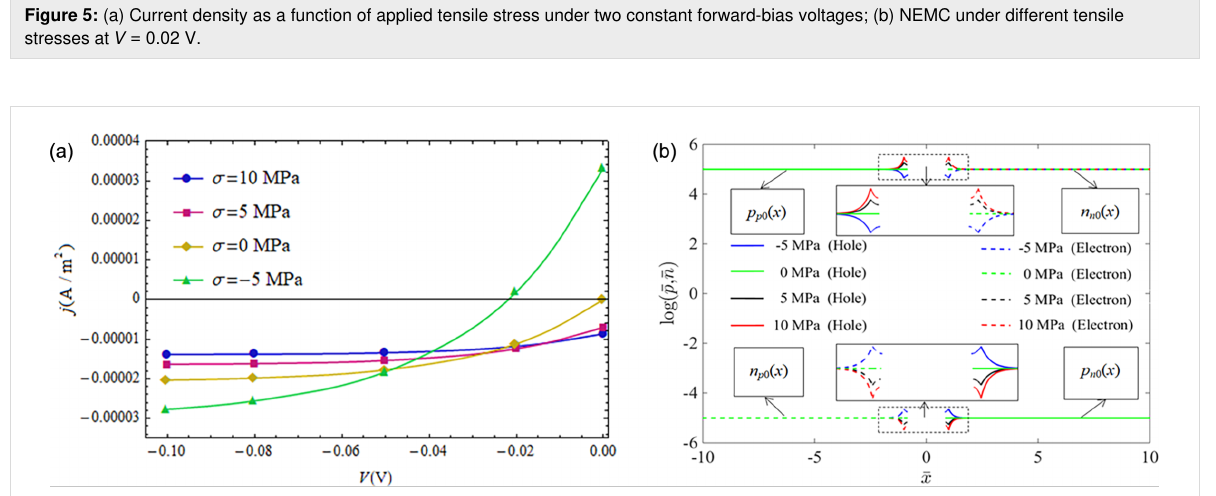
Figure 6: (a) I – V characteristics of a piezoelectric p–n junction under reverse-bias voltages and different applied stresses; (b) distribution of the initial carrier concentrations for V = − 0.10 V.